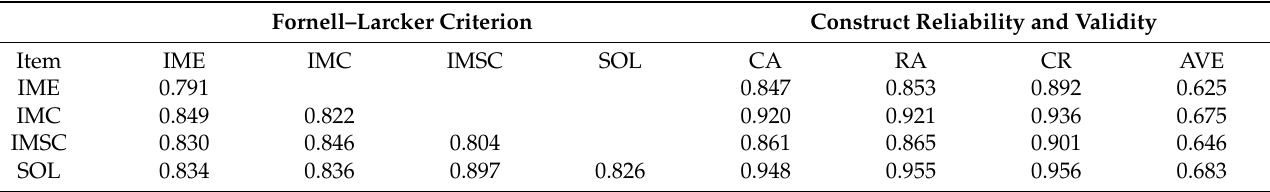
Table 7. Overall validity and